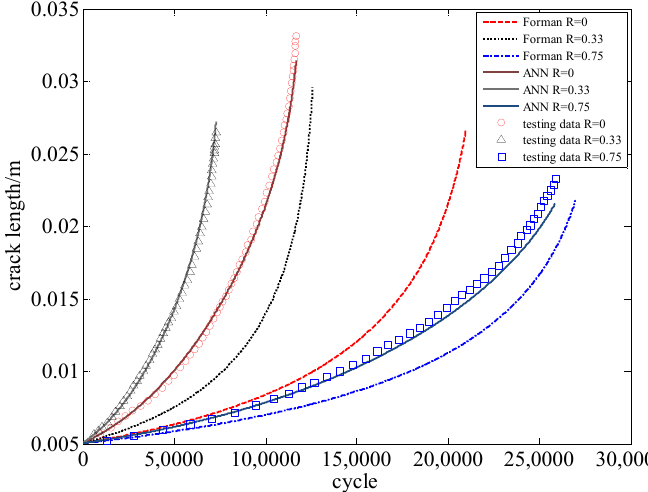
Figure 17. The predictions vs. the experimental data for D16 aluminum alloy.